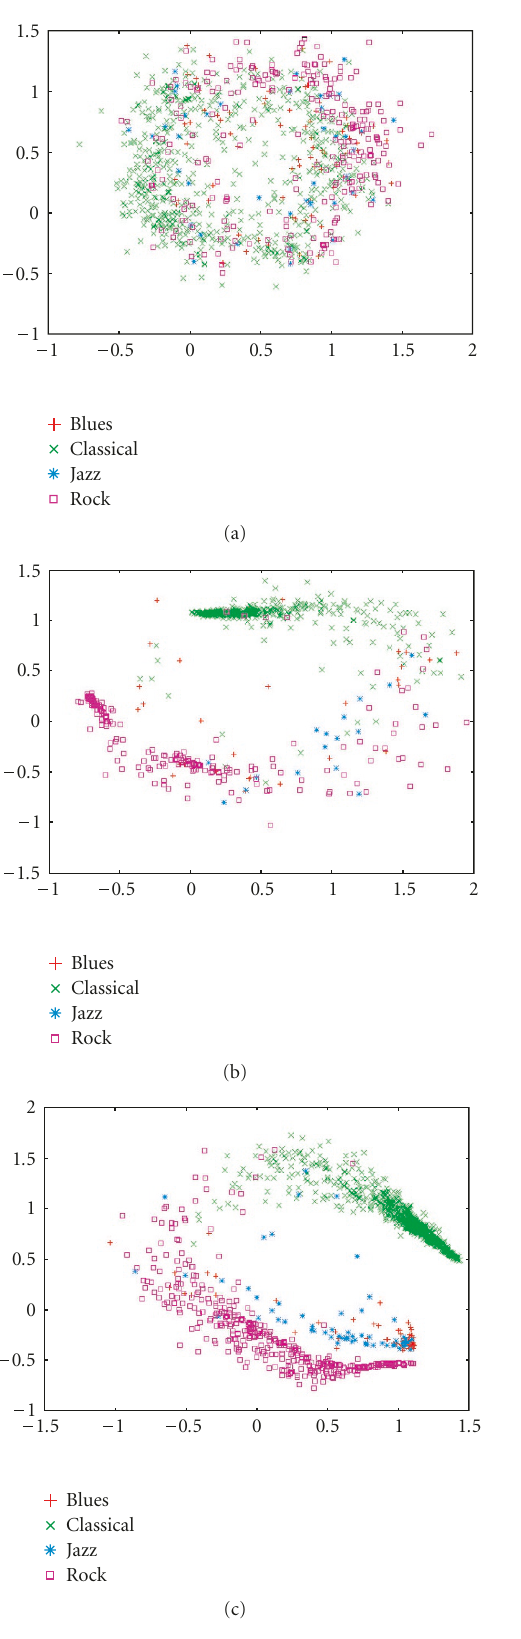
Figure 3: Similarity spaces produced by (a) Marsyas features, (b) an LDA genre model, and (c) a CART-based model.